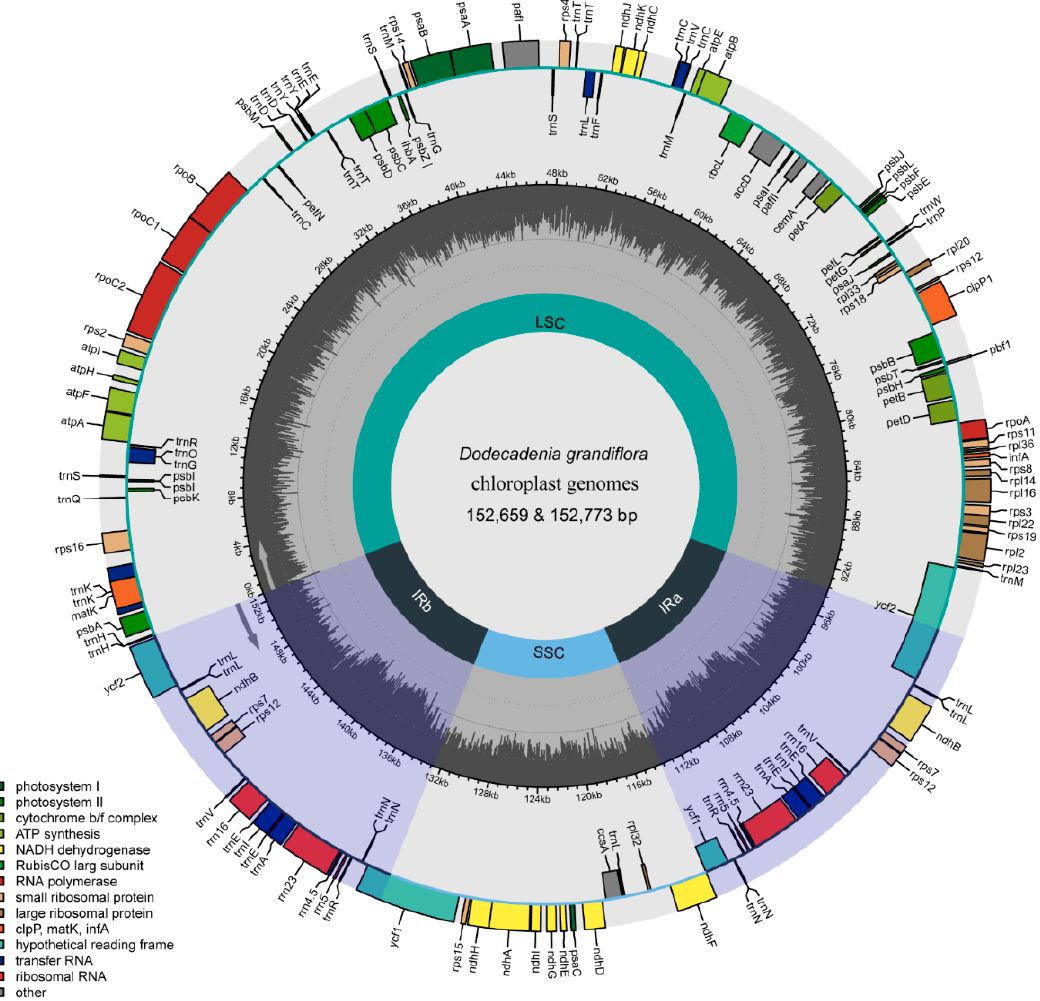
Figure 1. Gene map of D. grandiflora plastomes.